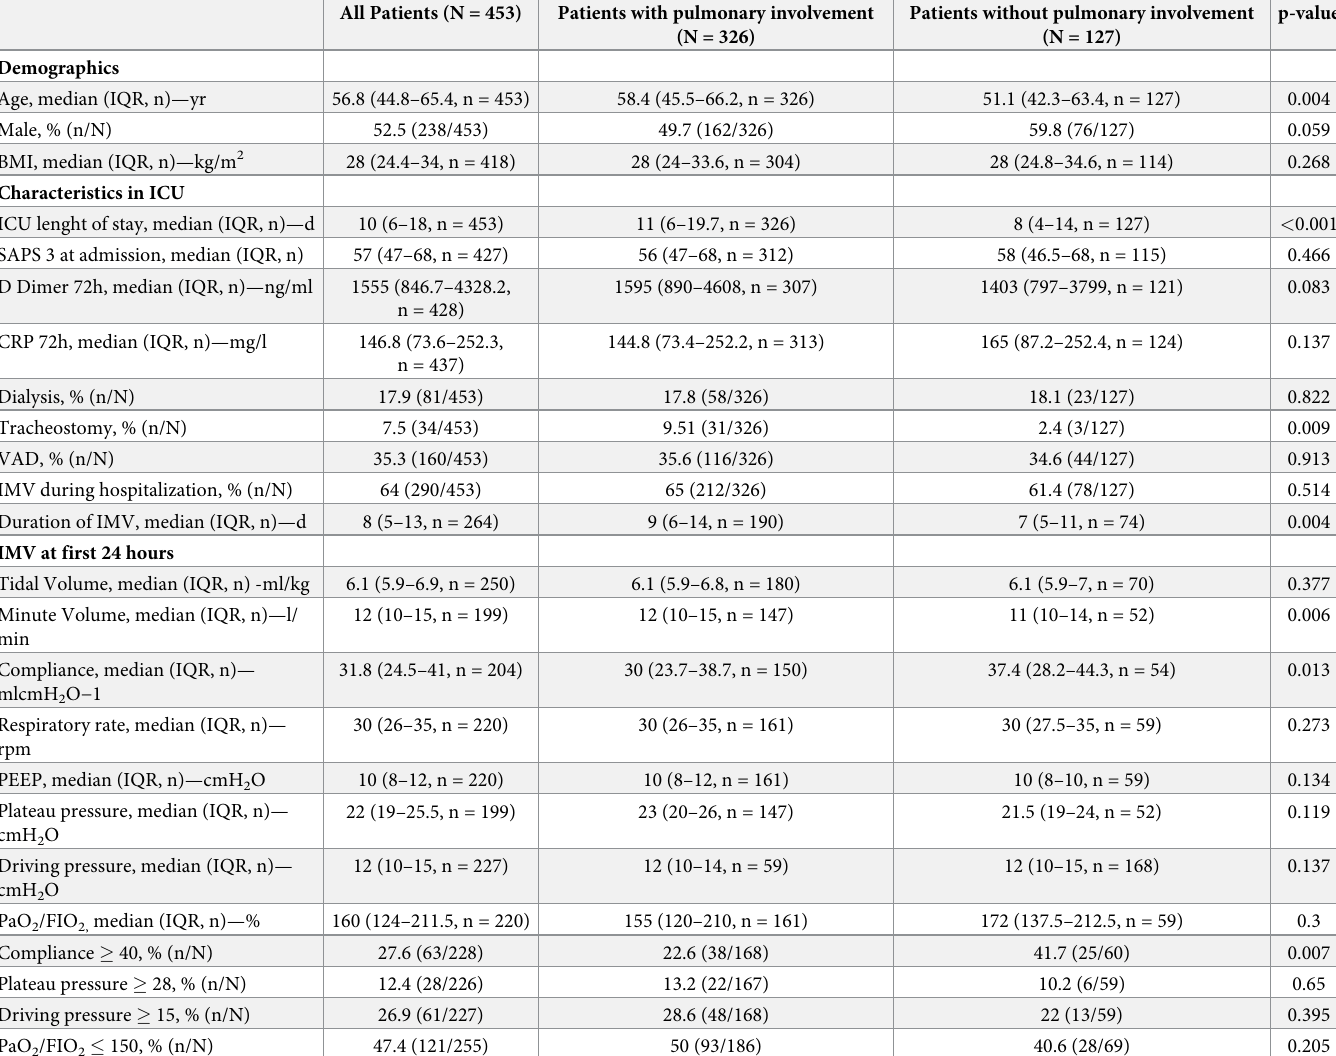
Table 1. Baseline demographic and clinical characteristics of enrolled patients that underwent the general